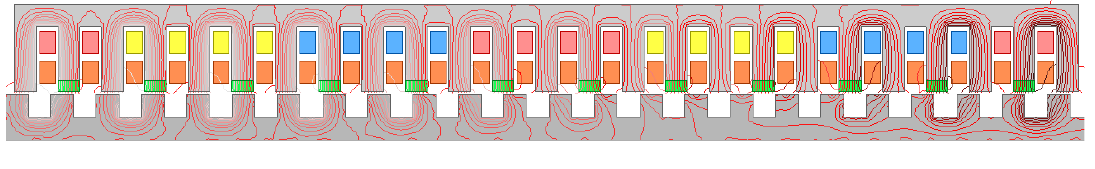
Figure 6. Distribution of the PM flux.